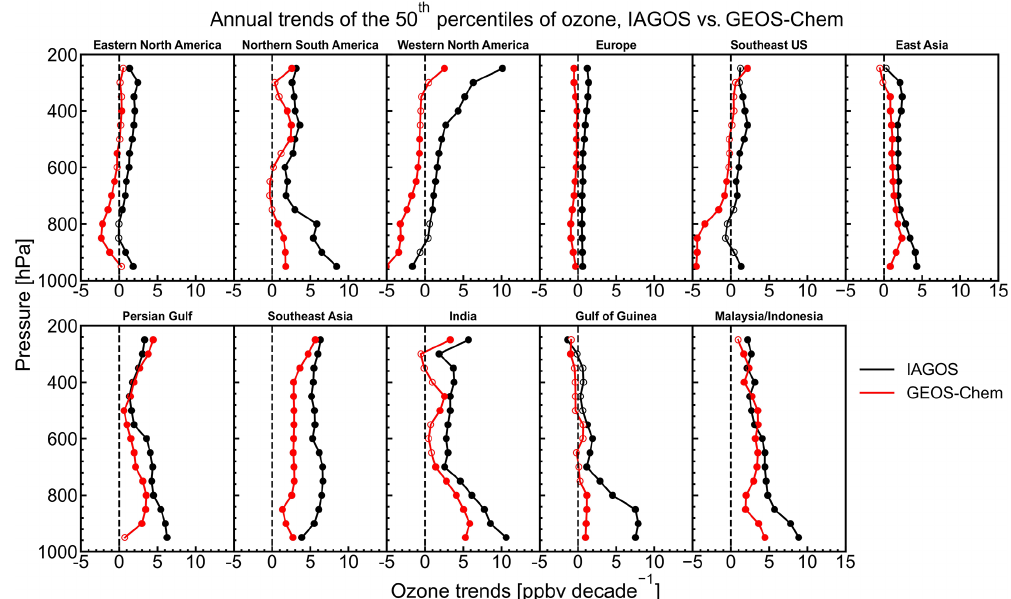
Figure 5. Annual trends of the 50th percentiles of IAGOS observed and GEOS-Chem simulated ozone (ppbv per decade) at intervals of 50hPa. The trends are calculated between 1995 and 2017 above the 11 selected regions (Fig. 1) using the quantile regression method (Sect. 2.5). Filled circles indicate trends with p < 0 .